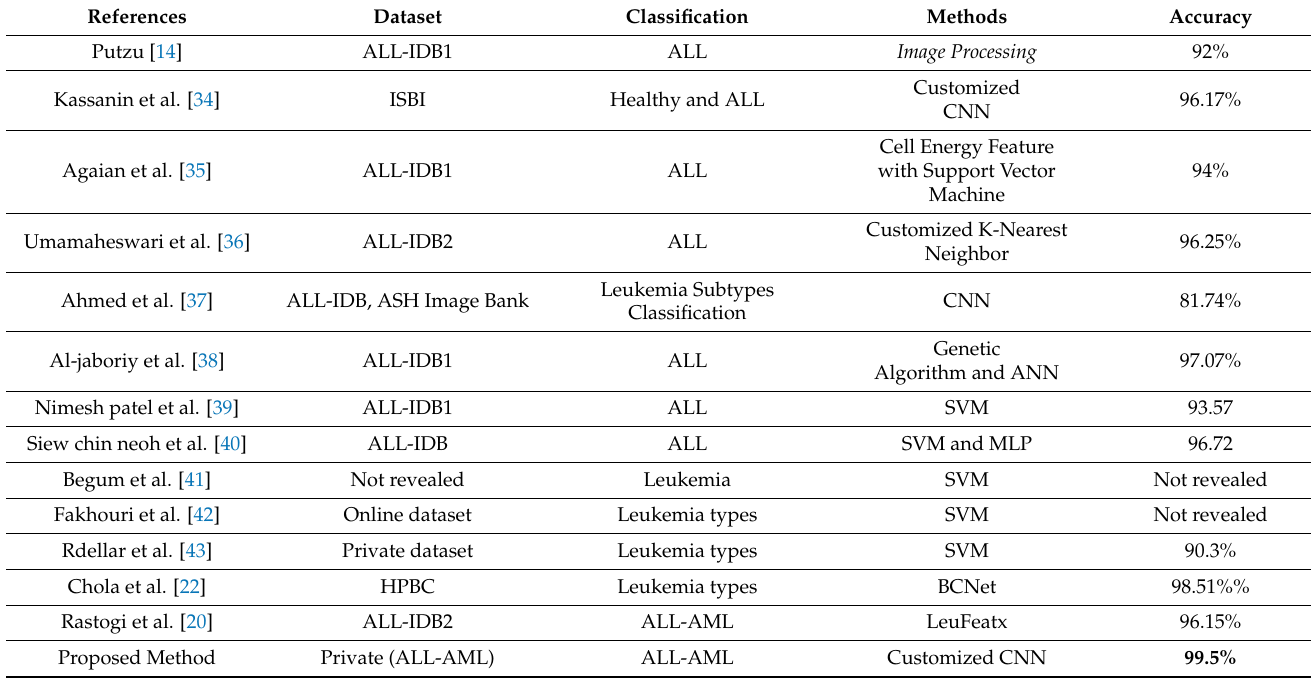
Table 2. The leukemia diagnostic accuracy of various methods.